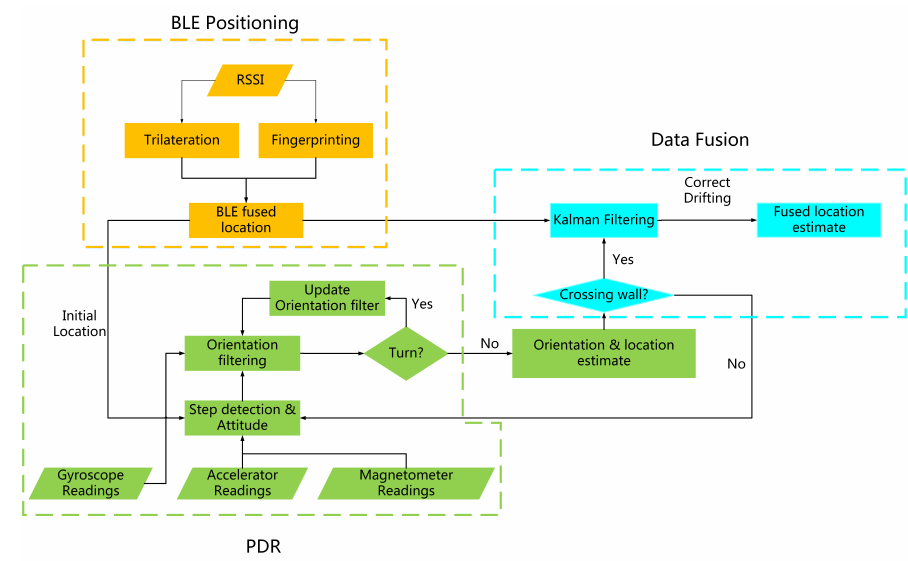
Figure 1. The data fusion workflow of Bluetooth Low Energy (BLE) positioning and pedestrian dead reckoning (PDR)